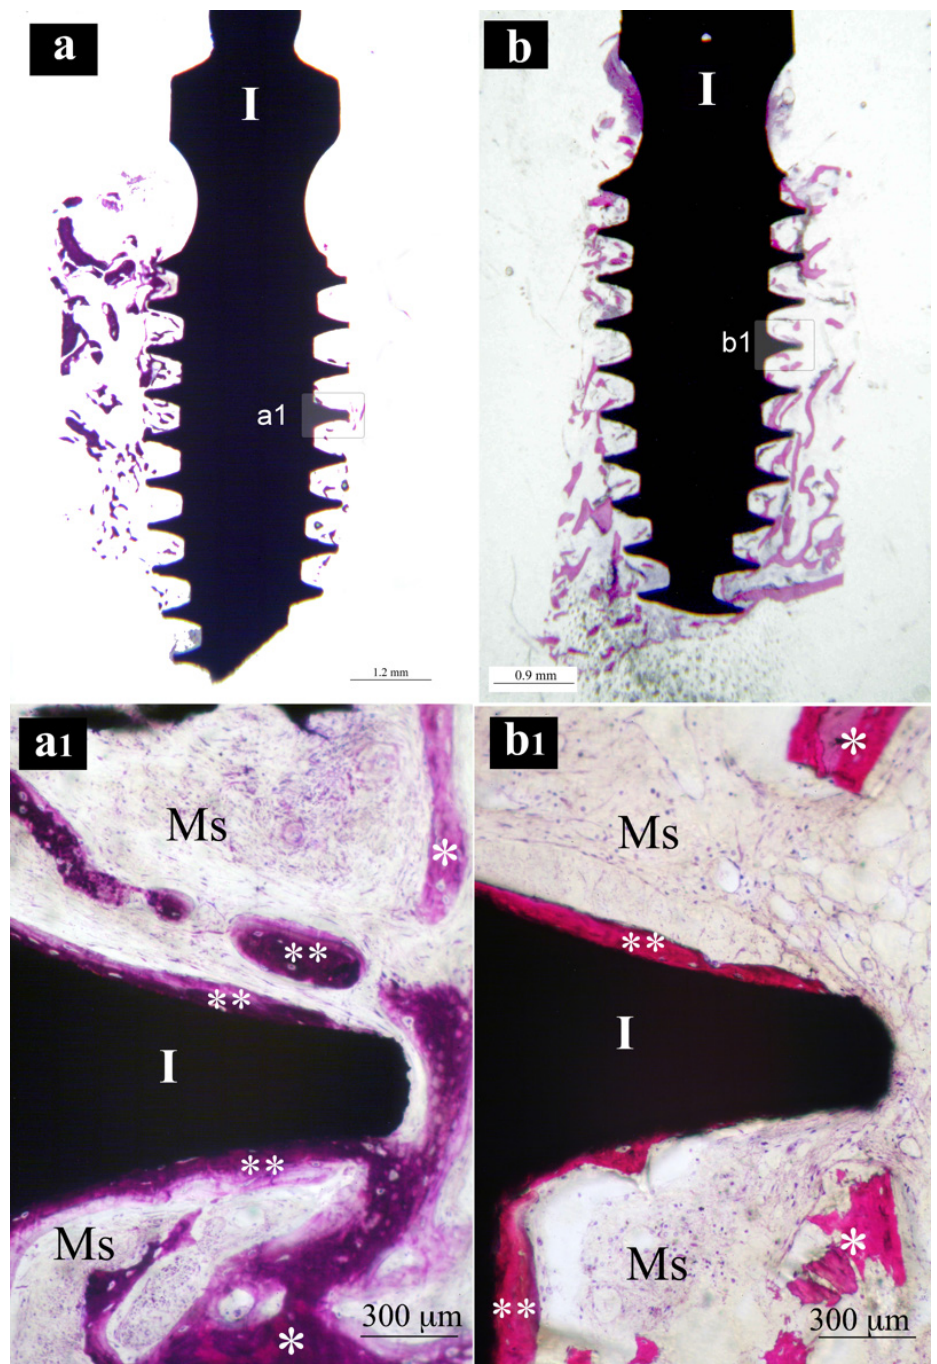
Figure 6. Central sections of two implants of the XPEED group after 6 weeks of healing. In ( a , b ), original magnifications ( × 12), the implant bodies (I), along the entire threaded regions, appear to be surrounded by an increase amount of mineralized bone compared to Figure 5. In ( a1 ), original magnifications ( × 200), the implant threads (I) appear to be in contact with a layer of newly formed bone (**); Ms, marrow space; *, native bone. In ( b1 ), original magnifications ( × 2000), the implant threads (I) appear to be almost completely harvested by thin layer of newly formed bone (**) with islands of native bone